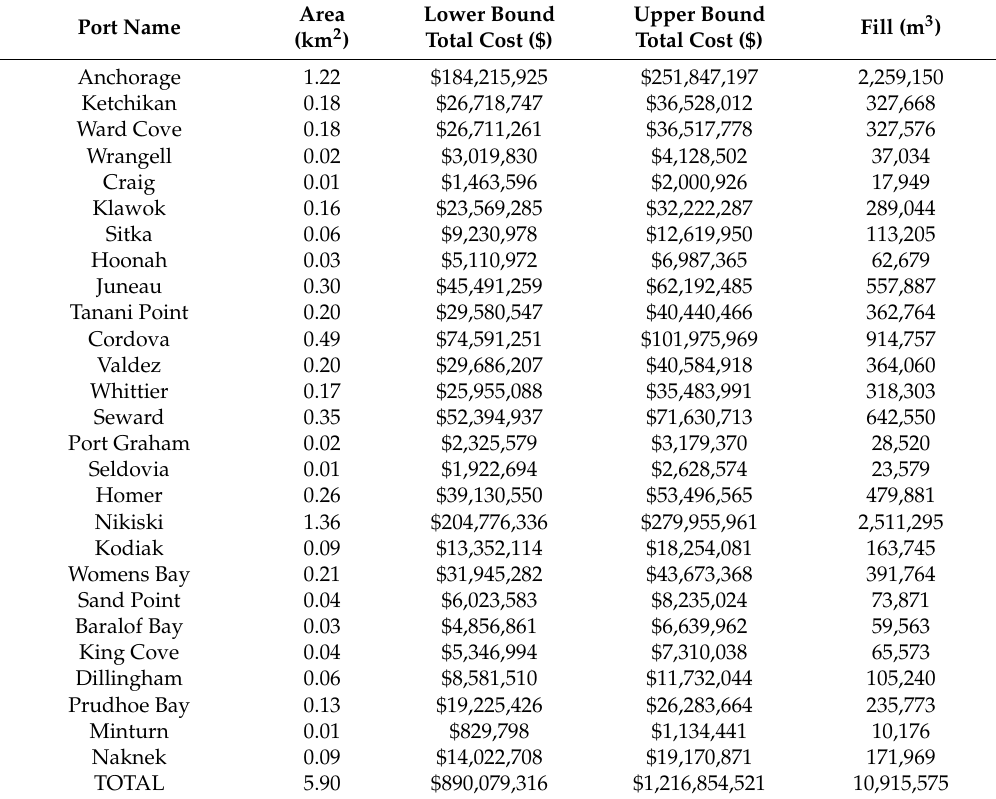
Table A5. Cost and Materials Required to Elevate and Retrofit Alaska Seaports in Response to two meters of Sea Level